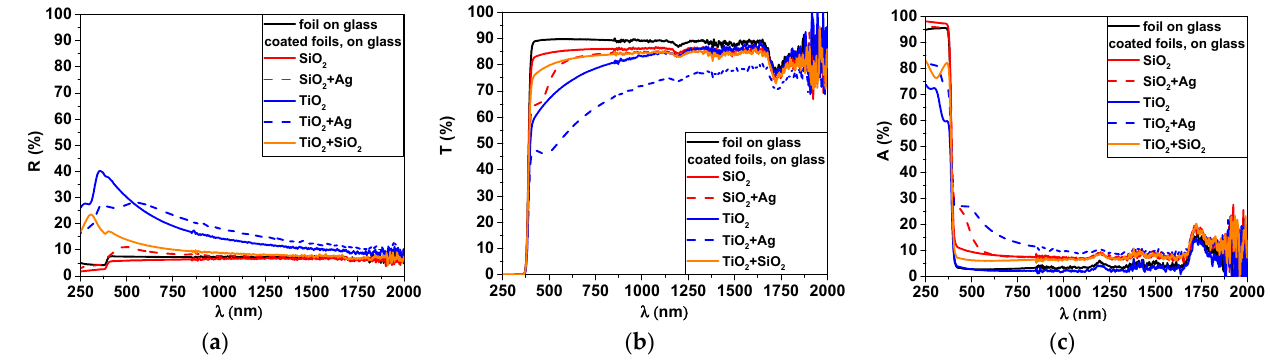
Figure 8. Spectrophotometric curves, reflectivity ( a ), transmittance ( b ) and absorbance ( c ) of the un- coated foil and the foils coated with SiO 2 , SiO 2 + Ag, TiO 2 , TiO 2 + Ag, TiO 2 + SiO 2 .